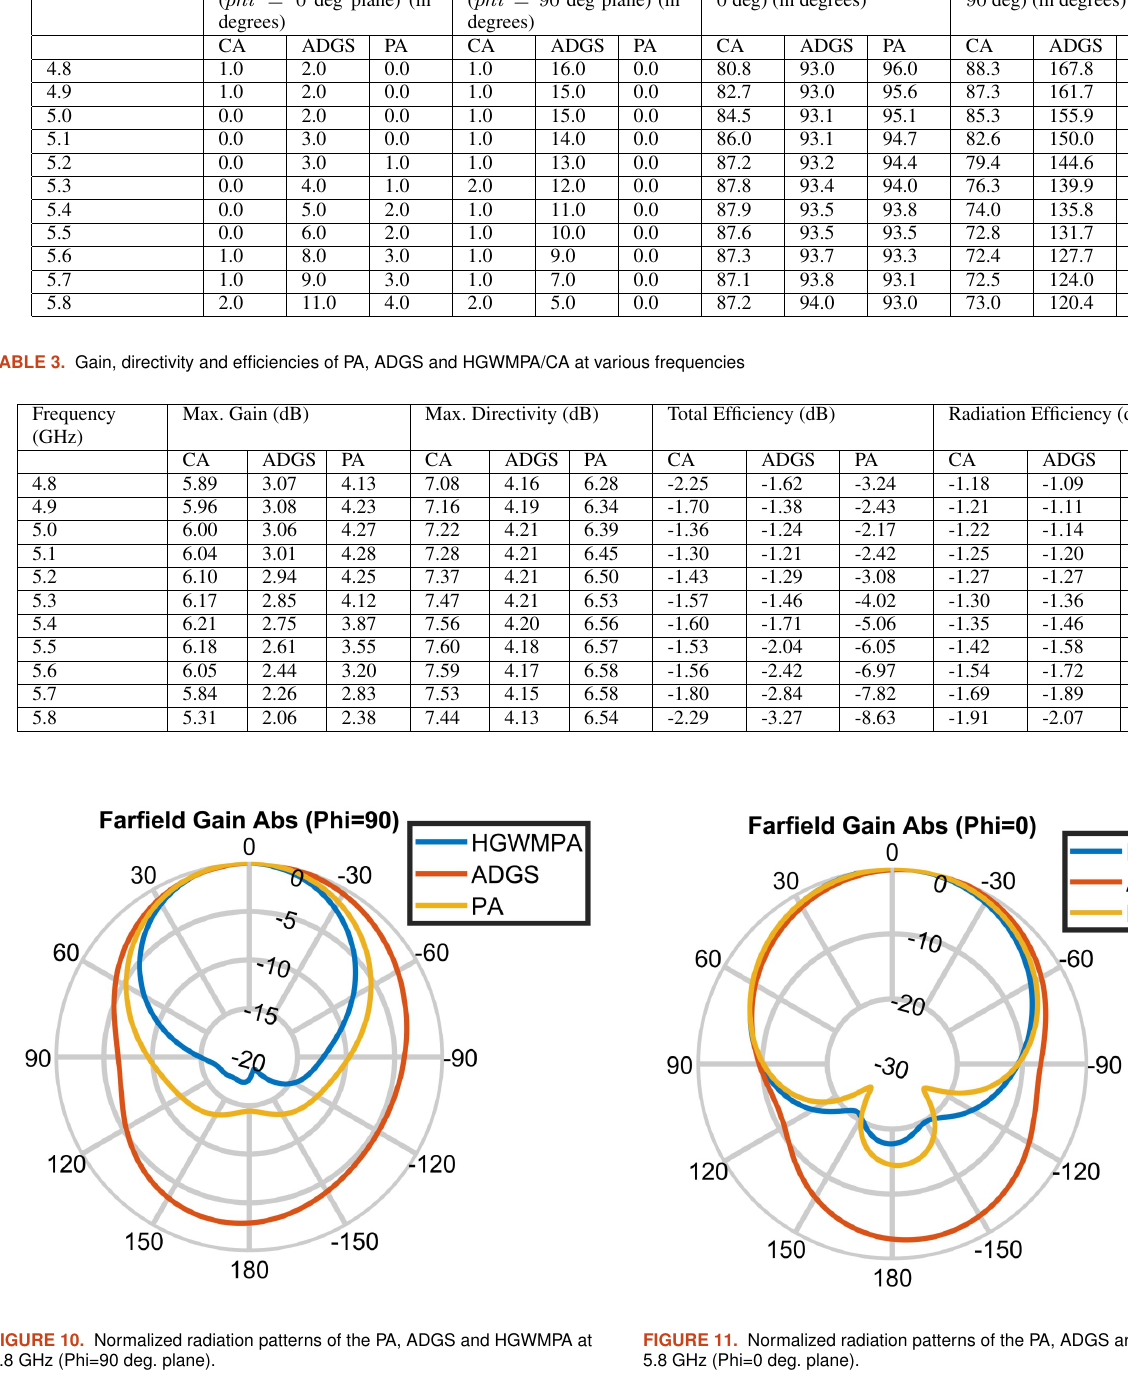
TABLE 2. Main lobe direction and 3 dB beamwidth of PA, ADGS and HGWMPA/CA at various frequencies Frequency (GHz)